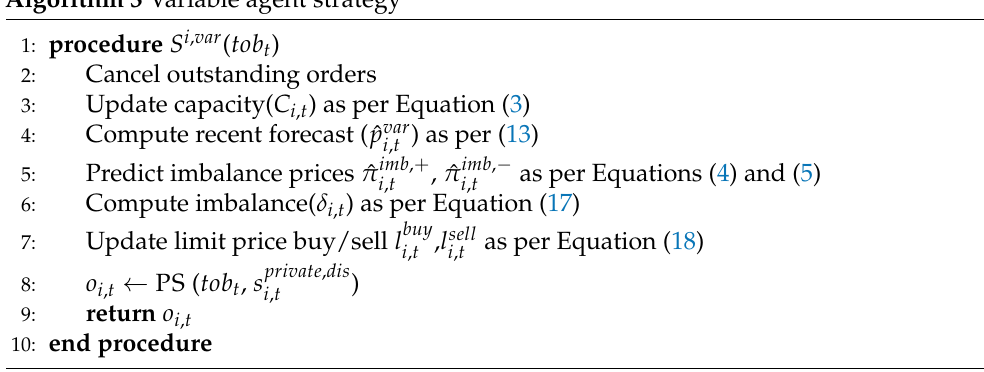
Algorithm 3 Variable agent